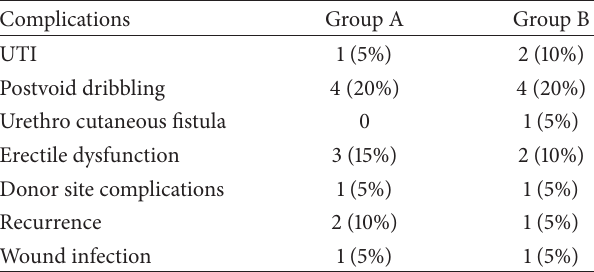
Table 3: Complications as observed